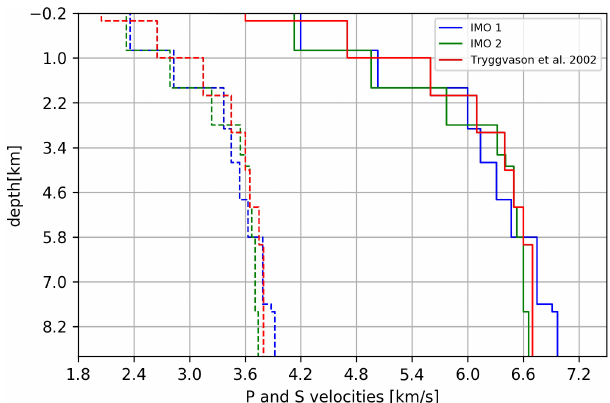
Figure 3. Three 1-D velocity models for P (solid lines) and S (dashed lines) waves tested.